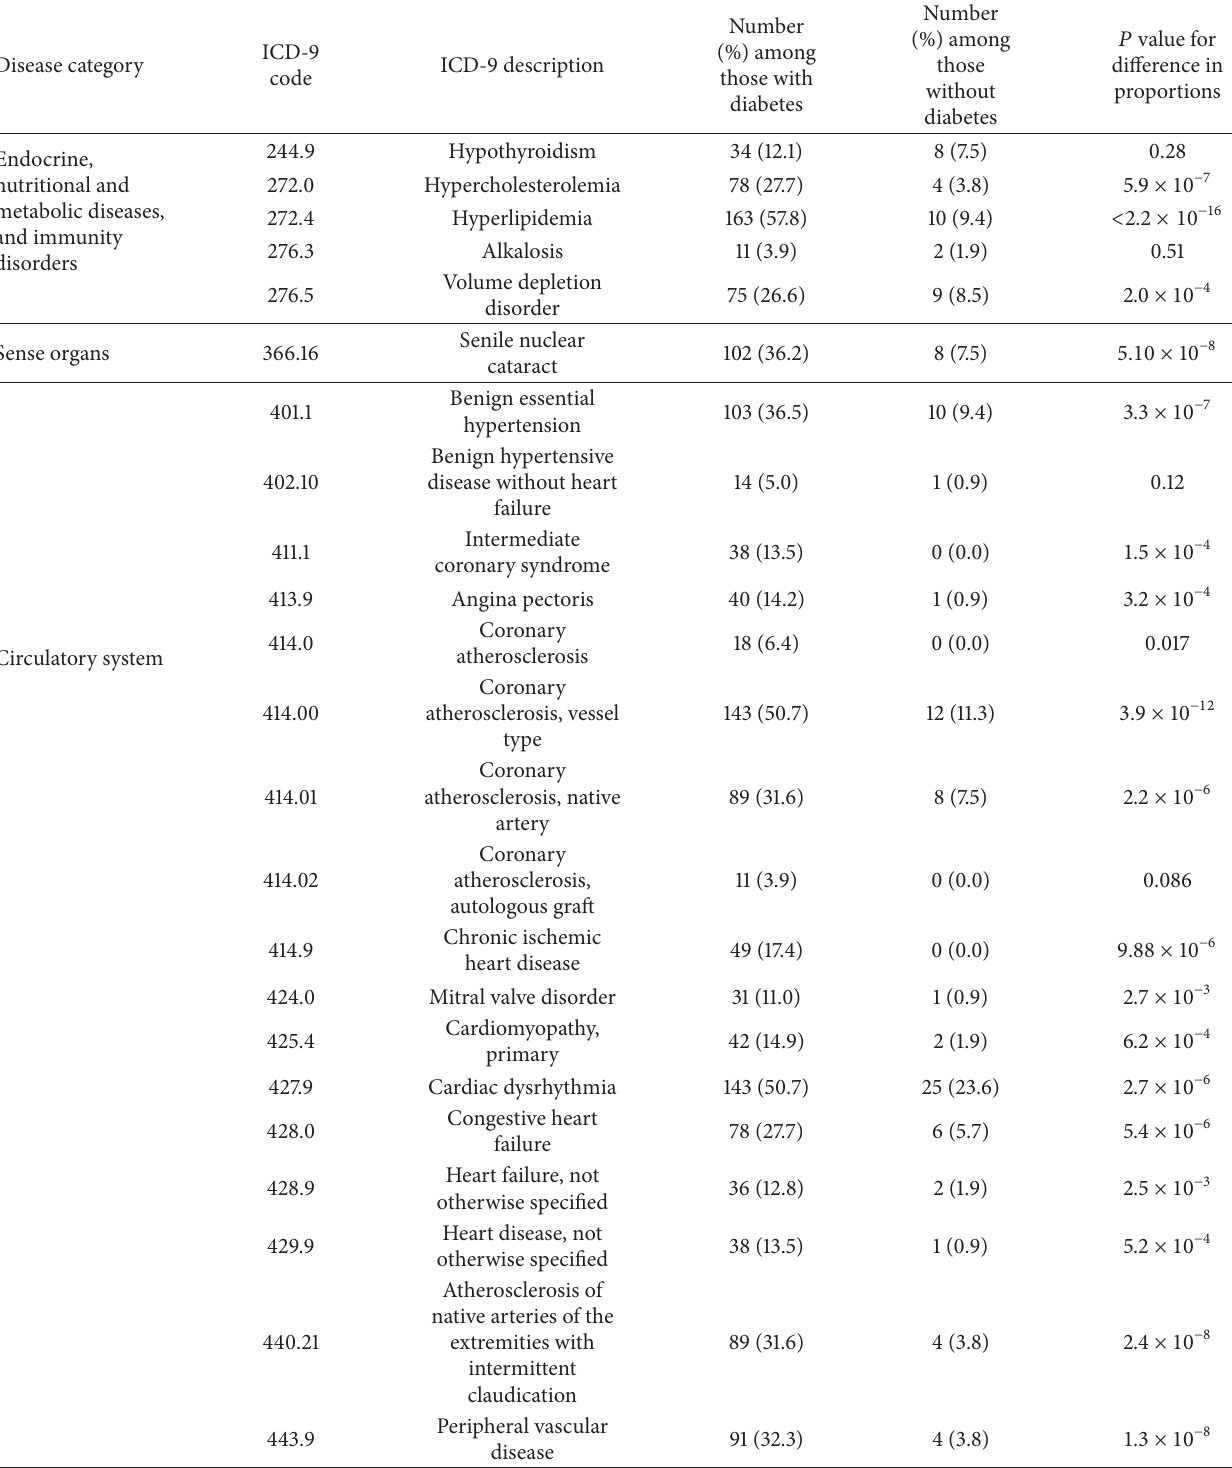
Table 4: Novel or poorly know associations with Charcot foot, compared between those with ( 𝑛 = 282 ) and without ( 𝑛 = 106 ) diabetes, defined as any ICD-9 250.x code. The associations shown here are based on the ones shown in Table 2. Disease category